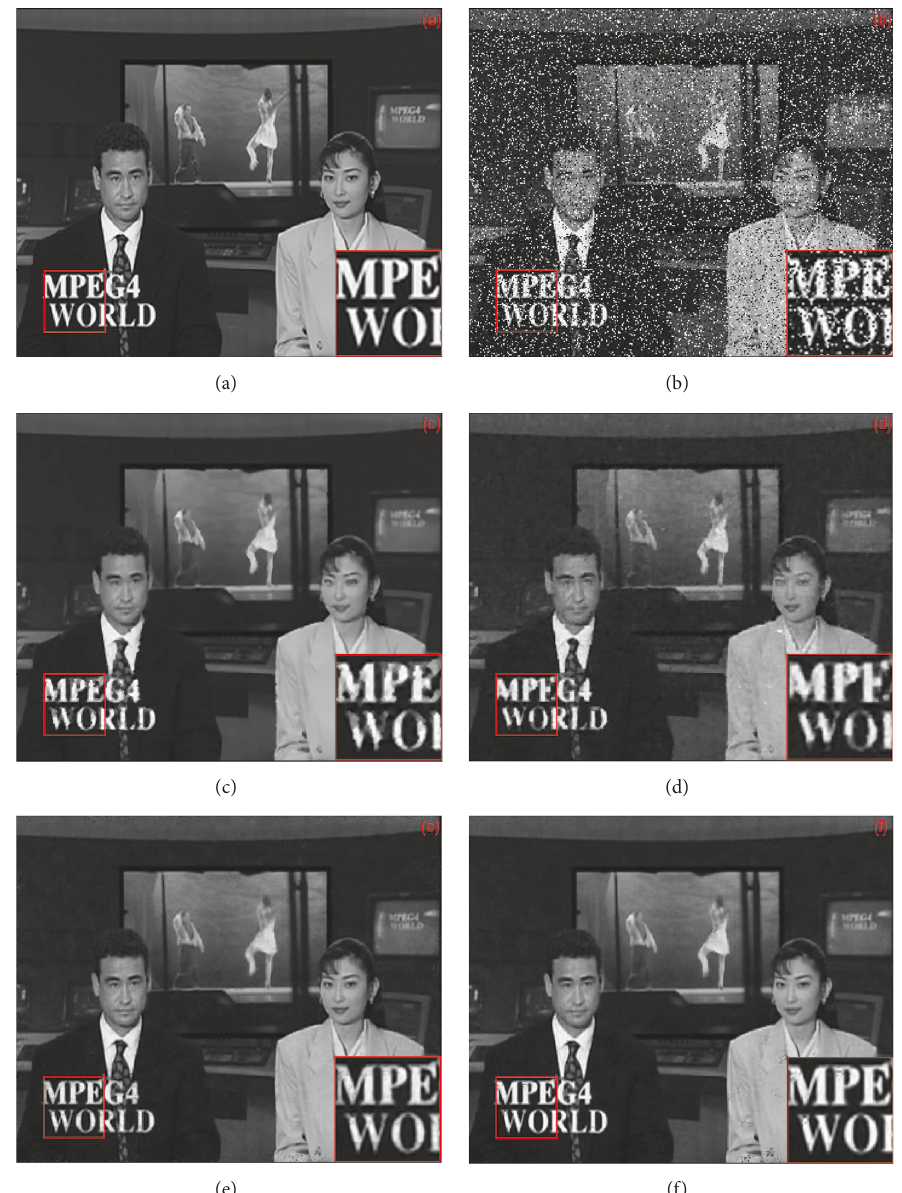
Figure 3: Visual comparison of denoising results by noise level (15,15 % ,15 % ) . (a) Original sample (news) , (b) noisy image, (c) VBM3D based method (PSNR = 26.23 ), (d) RPCA based method (PSNR = 24.60 ), (e) ℓ 1 - ℓ 0 based method (PSNR = 24.87 ), and (f) the proposed method (PSNR = 28.01 , 𝑘 = 2000